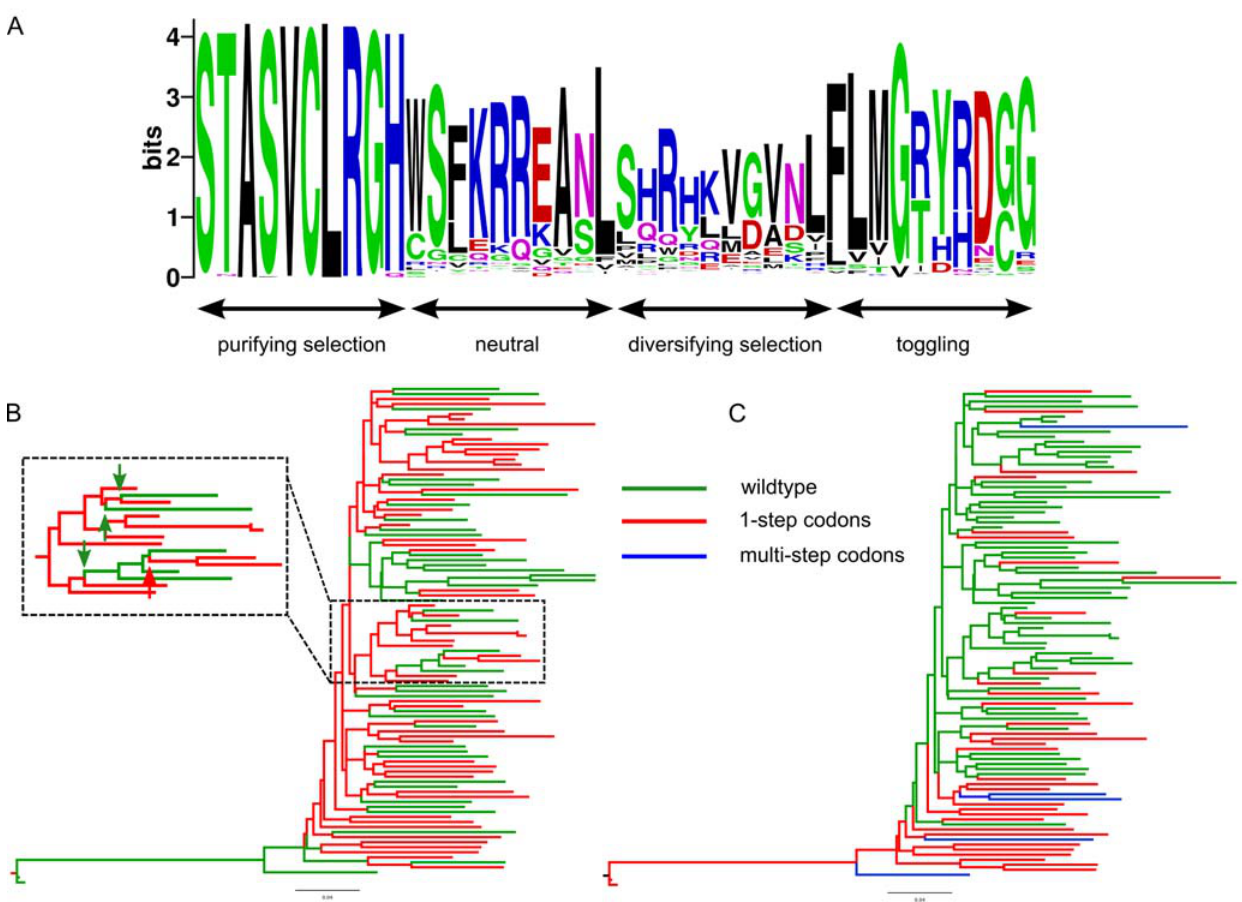
Figure 2. Simulation along HIV-1 nef phylogeny. Data was simulated under purifying selection, neutrality, diversifying selection, or toggling to evaluate power and false positives rates. (A) Amino acid sequence logos [73] of ten randomly drawn codon sites for each category of simulated site. (B) Simulated toggling site mapped to HIV-1 phylogeny showing the occurrence of escape (red arrows) and reversion (green arrows) mutations. (C) Simulated diversifying selection site mapped to HIV-1 phylogeny.